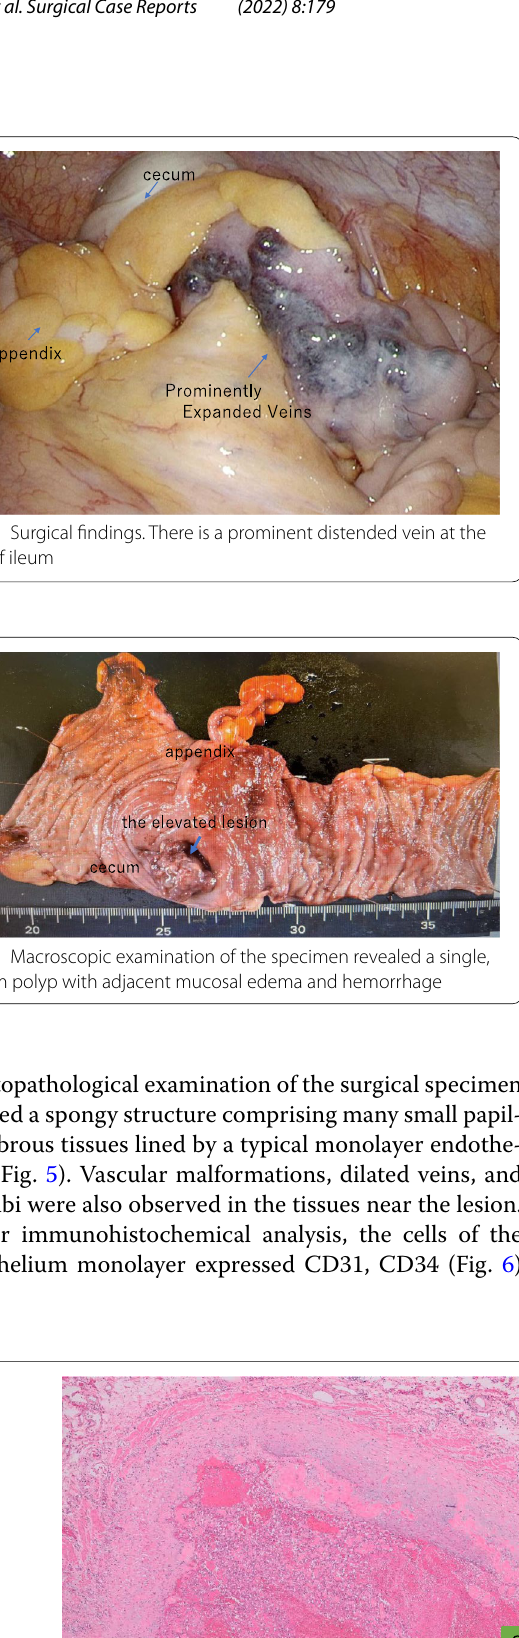
Fig. 5 Histology findings. a Hematoxylin and eosin (HE) staining, 40 vascular channels, papillary structures and an organizing thrombus confined to the vascular